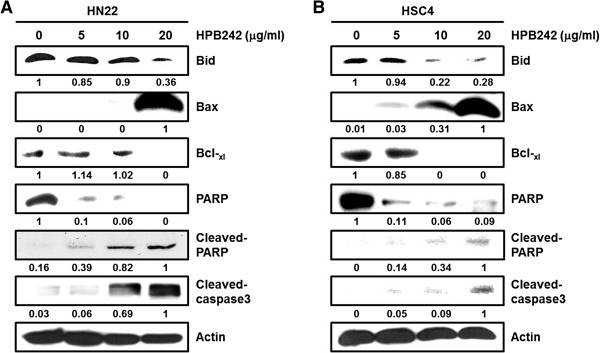
The effect of HPB242 on apoptosis of HN22 and HSC4 cells. HN22 (A) and HSC4 (B) cells were incubated with HPB242 (0, 5, 10 and 20 μg/ml) for 48 h. Fifty micrograms of cellular extract per lane was separated on an SDS-PAGE gel as described in Methods. Immunoblot detection of Bid, Cleaved-caspase3, and PARP, upregulation of Bax, downregulation of Bcl-xl in whole cell lysates from various concentration HPB242-treated HN22 and HSC4 cells for 48 hours. Equal loading of protein was confirmed by incubating the same membrane with anti-β-Actin antibody.